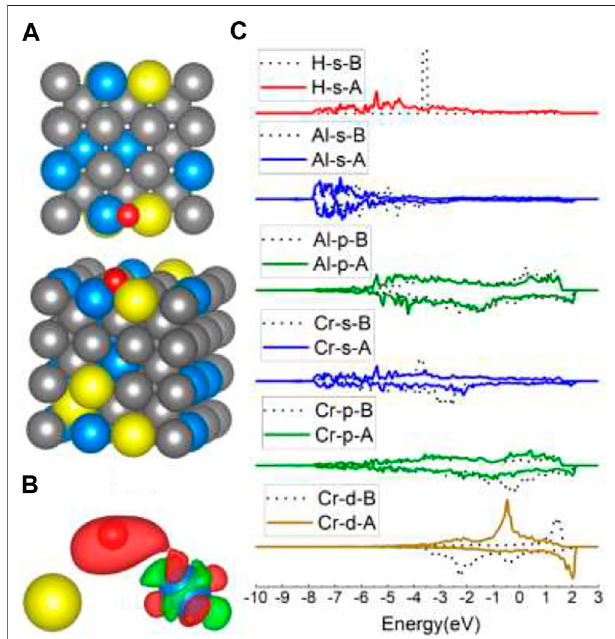
FIGURE 8 | The optimized structure, charge density difference, and DOS of the Al – Cr bridge site after the hydrogen atom is adsorbed on the FeCrAl (100) surface: (A) top and side view of the H-slab structure, (B) charge densitydifference(theisosurfaceofchargedifferenceis0.007electrons/ Bohr 3 ),red colorrepresentschargeaccumulation,andgreencolorrepresents charge depletion, and (C) DOS before and after H atom adsorption, the black dotted lines represent s / p / d orbitals before H atom adsorption, and B/A represents before and after, respectively.